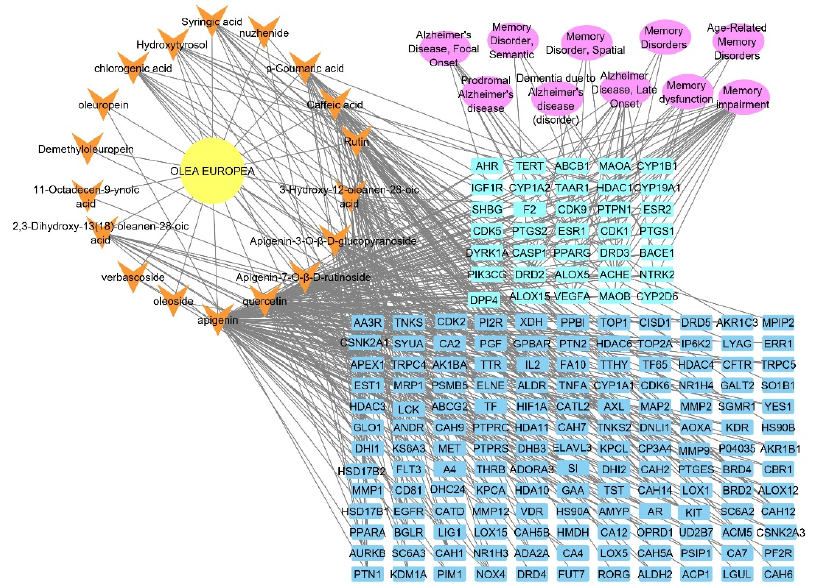
Figure 5. Plant–compounds–target genes–Alzheimer and memory disorders network (complete pharmacology network), the yellow circle is the plant name, fluorescent blue rectangle shapes represent the genes involved in Alzheimer disorders, orange arrowheads represent the identified compounds from Olea europaea L. cv. Picual, dark blue rectangles represent the targets not related to Alzheimer, and pink oval shapes represent different types of Alzheimer and memory disorders.